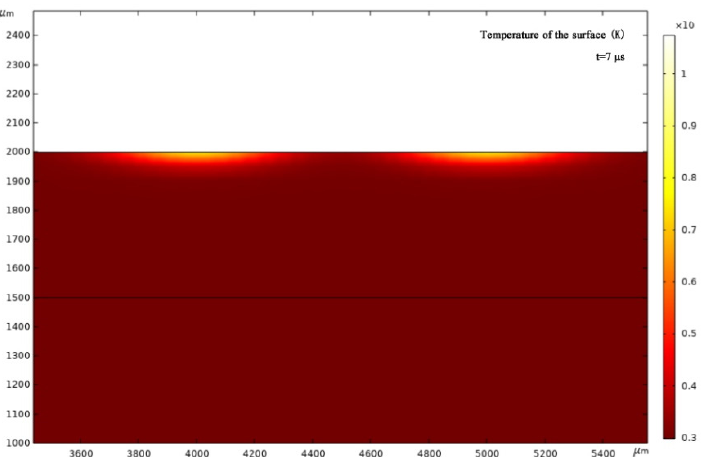
Figure 8. Temperature field distribution under non-shaped laser energy 60 W.